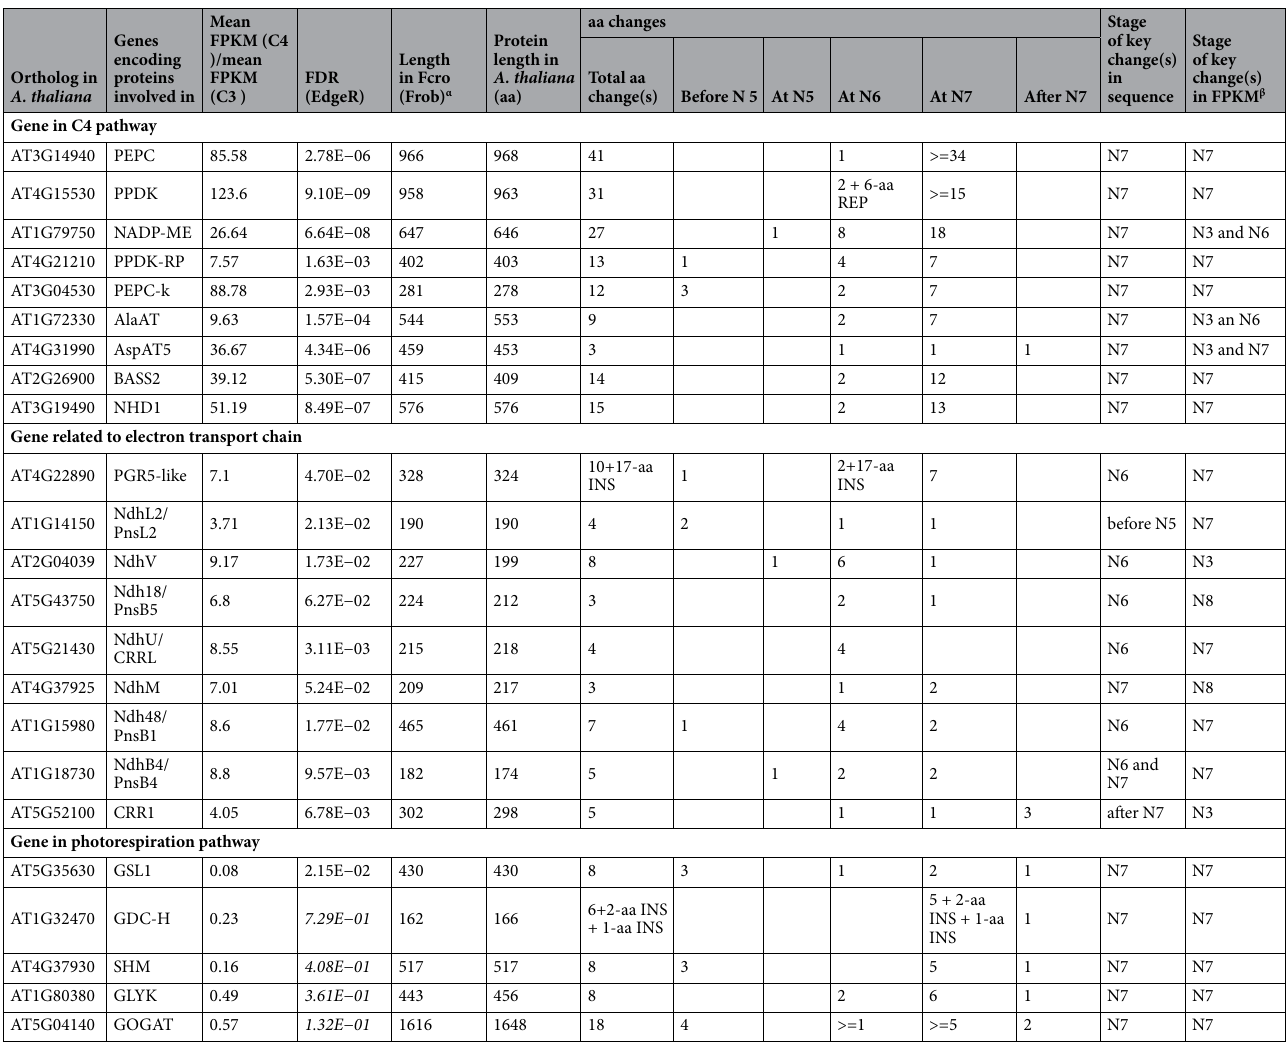
Table 1. Proteins showing differences in amino acid sequence between C 3 and C 4 Flaveria species and the relative changes in their cognate